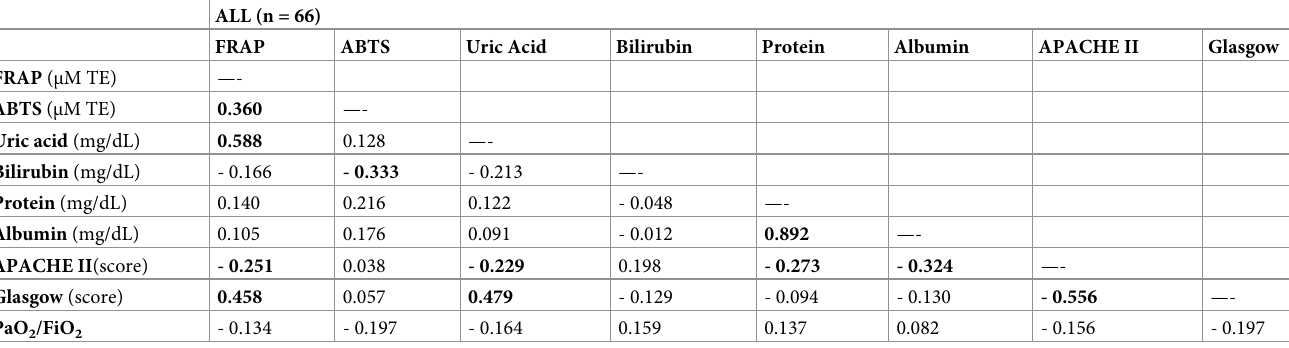
Table 3. TAC correlation with clinical